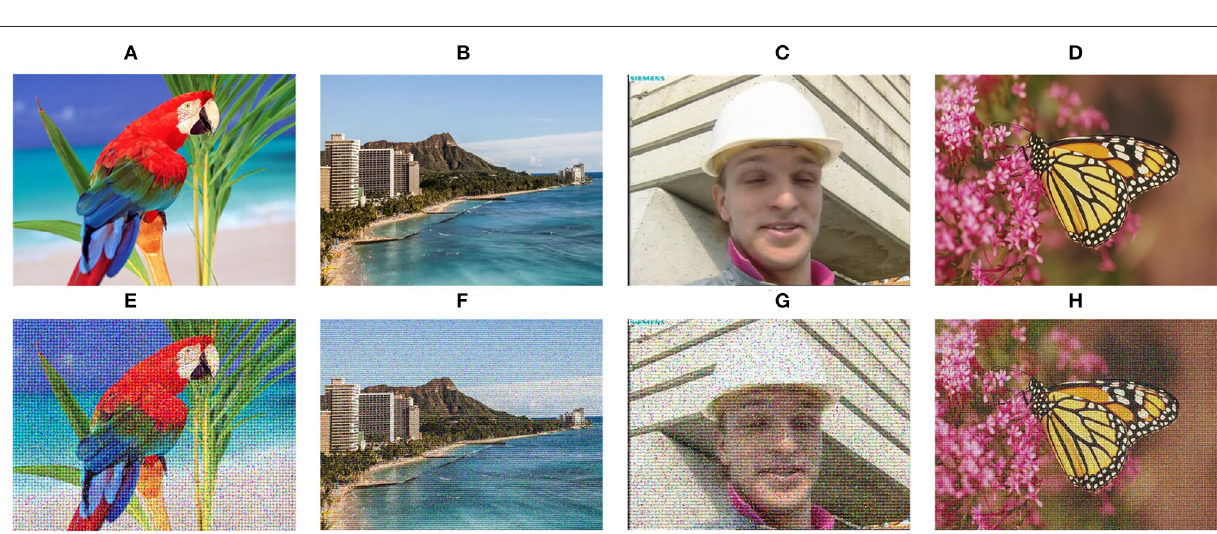
FIGURE 8 | Images used for quantitative evaluation. (A–D) Ground truth images; (E–H) Images with noise. Panel (A) is reproduced with permission from Ryo Abiko, Masaaki Ikehara, available at https://www.jstage.jst.go.jp/article/transinf/E102.D/10/E102.D_2018EDP7437/_pdf. Panel (B) is reproduced with permission from Xiaoyong Shen, Chao Zhou, Li Xu and Jiaya Jia, available at http://www.cse.cuhk.edu.hk/leojia/projects/mutualstructure/. Panels (C,D) are reproduced with permission from Chao Dong, Chen Change Loy, Kaiming He and Xiaoou Tang, available at